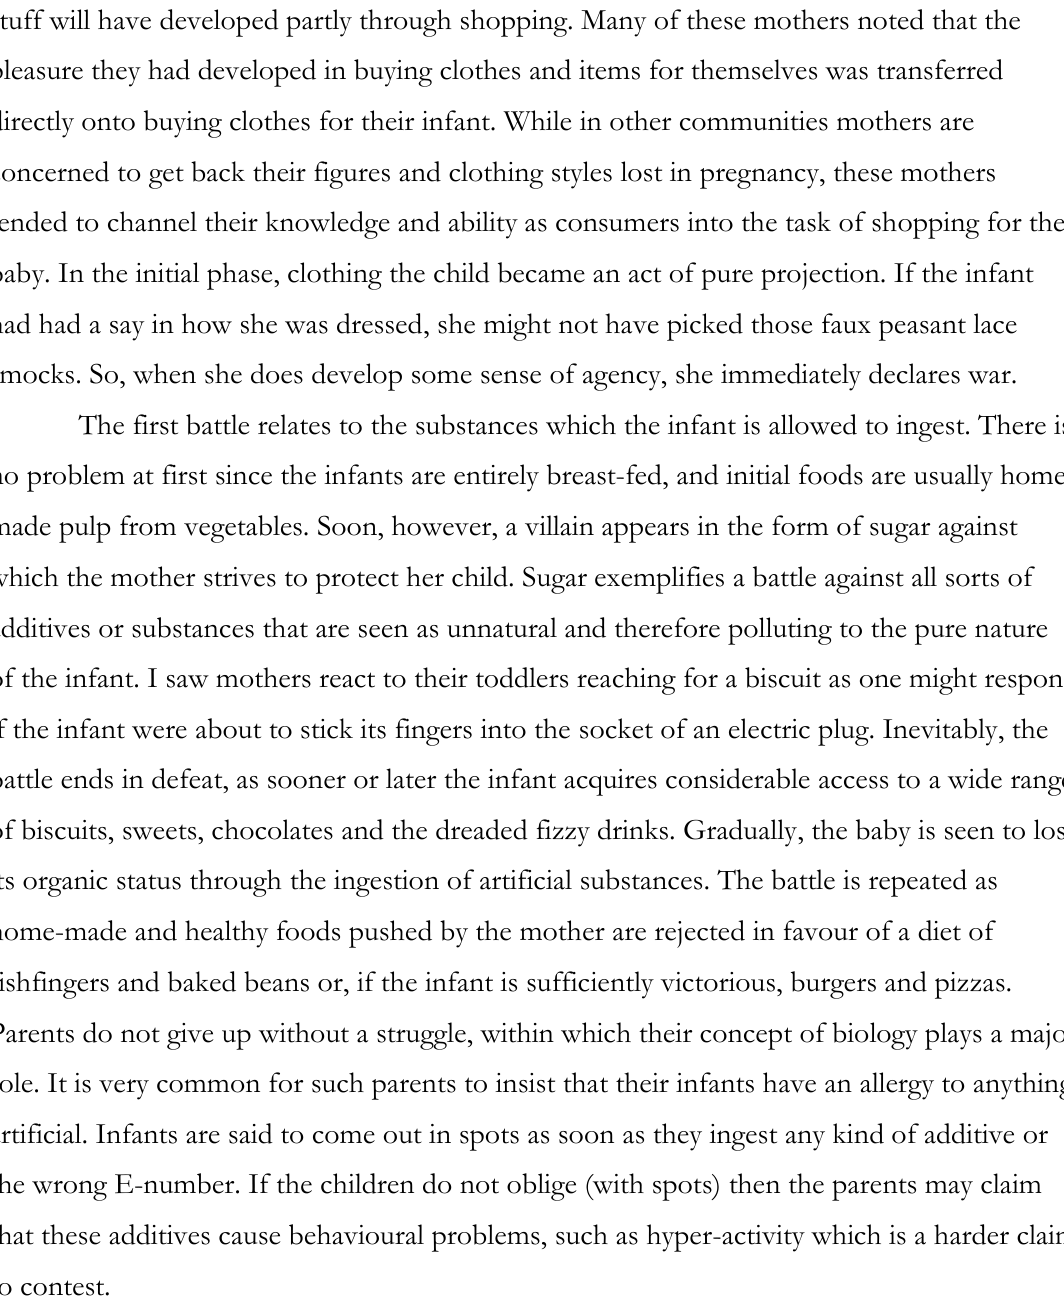
Daniel Miller: Getting THINGS Right: Motherhood and Material Culture Studies in the Maternal, 3(2), 2011,